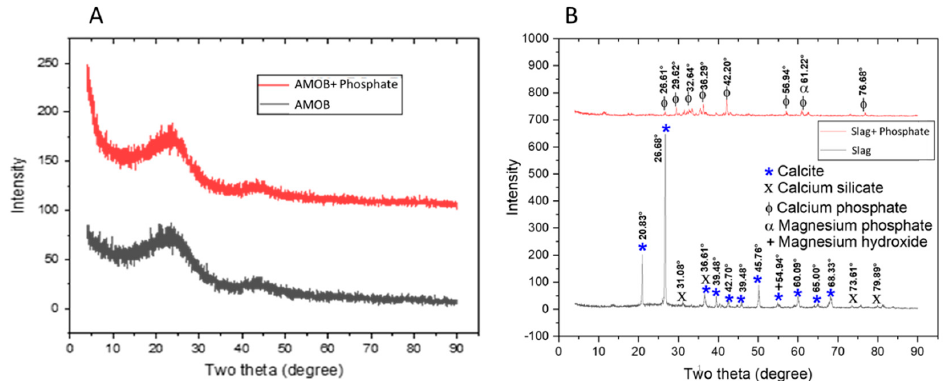
Figure 1. XRD spectra for ( A ) AMOB and ( B ) slag with and without the addition of phosphate.